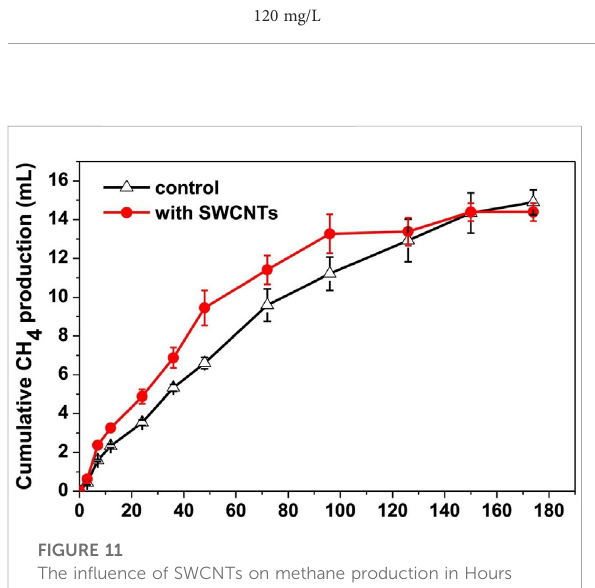
FIGURE 11 The in fl uence of SWCNTs on methane production in Hours (Li et al.,